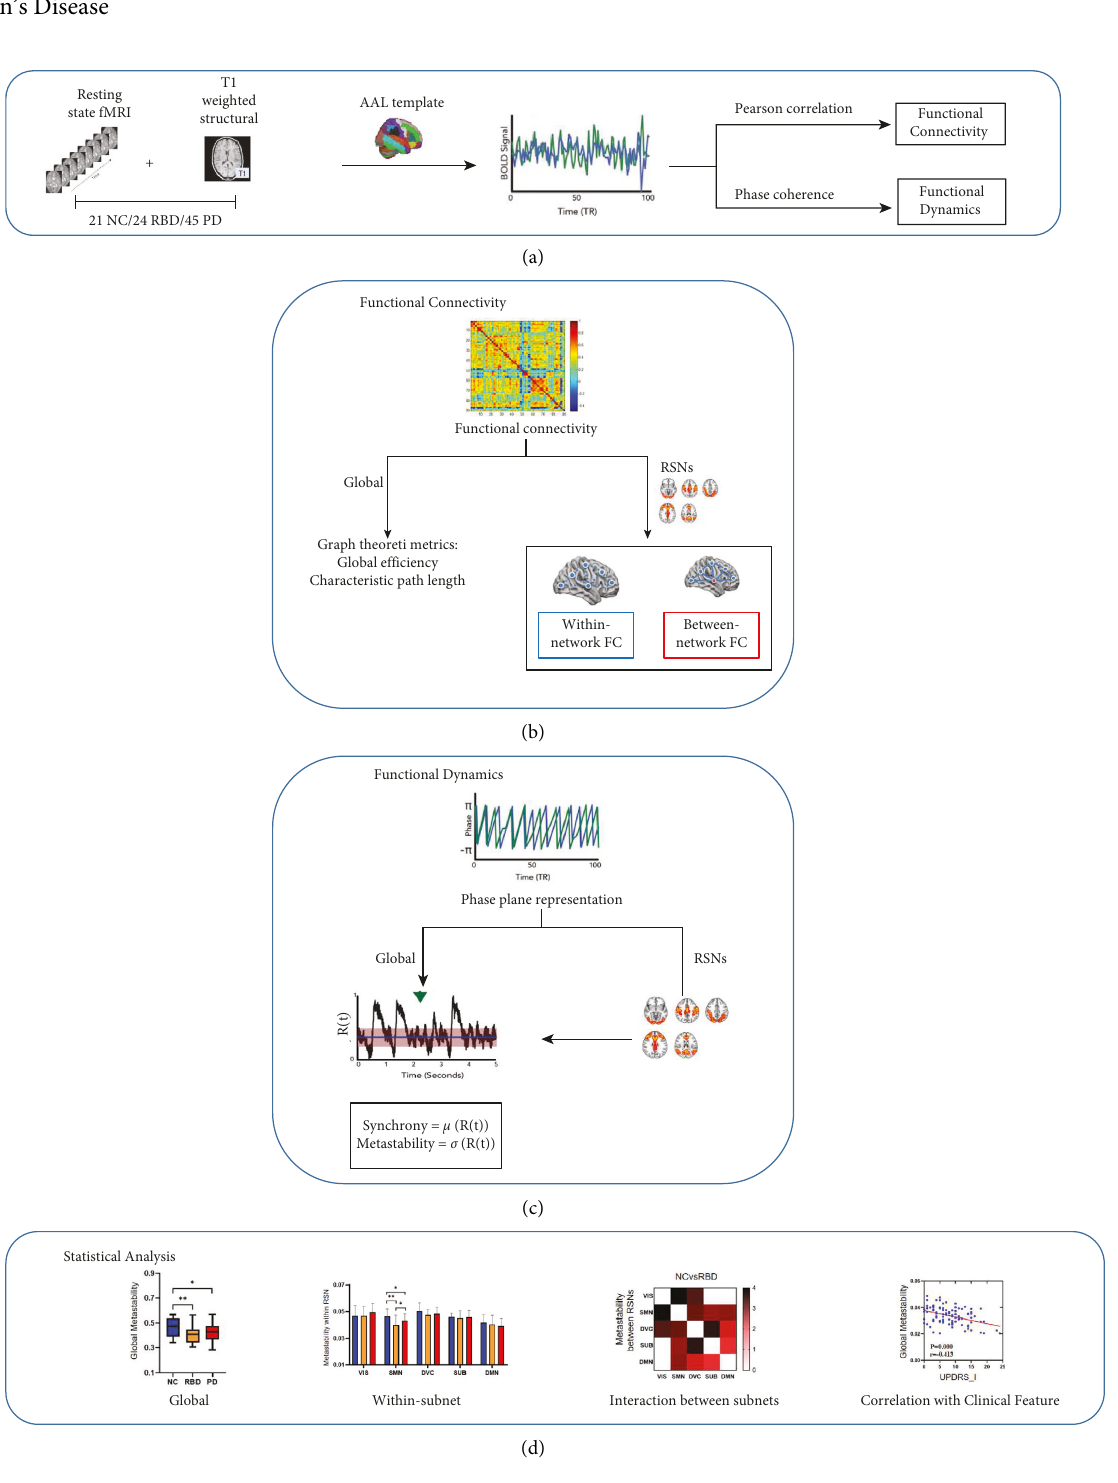
Figure 1: Technical route. (a) Functional image: data preprocessing and extraction time series. (b) Functional connectivity: calculation of global and RSNs indexes of FC. (c) Functional dynamics: calculation of synchrony and metastability from the perspective of global and RSNs. (d) Statistical analysis: analysis of neuroimaging measures differences and their relationship with clinical